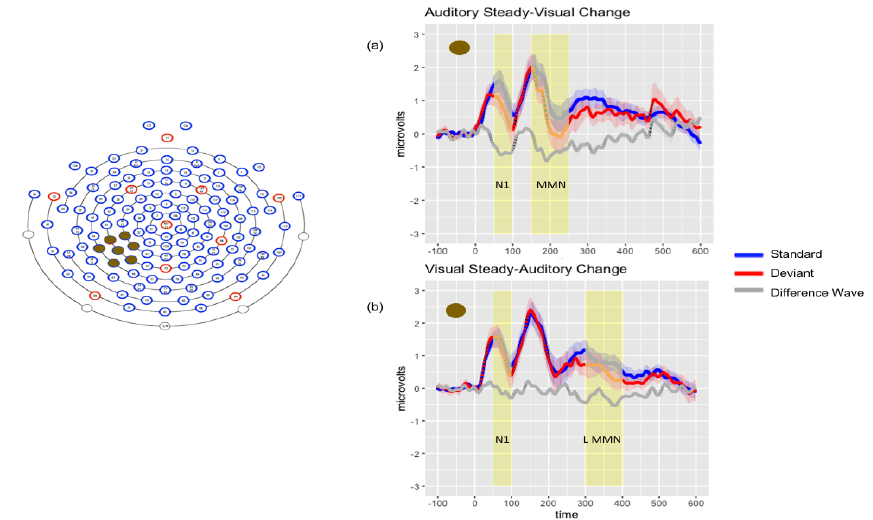
Figure 3. Left: Electrode montage for grand average waveforms of audiovisual conditions. Right: Grand average waveforms for AsVc (Panel a ) and VsAc (Panel b ) conditions. Solid lines represent the average response in microvolts across time in milliseconds; shaded lines represent the standard error of the means at each time point.